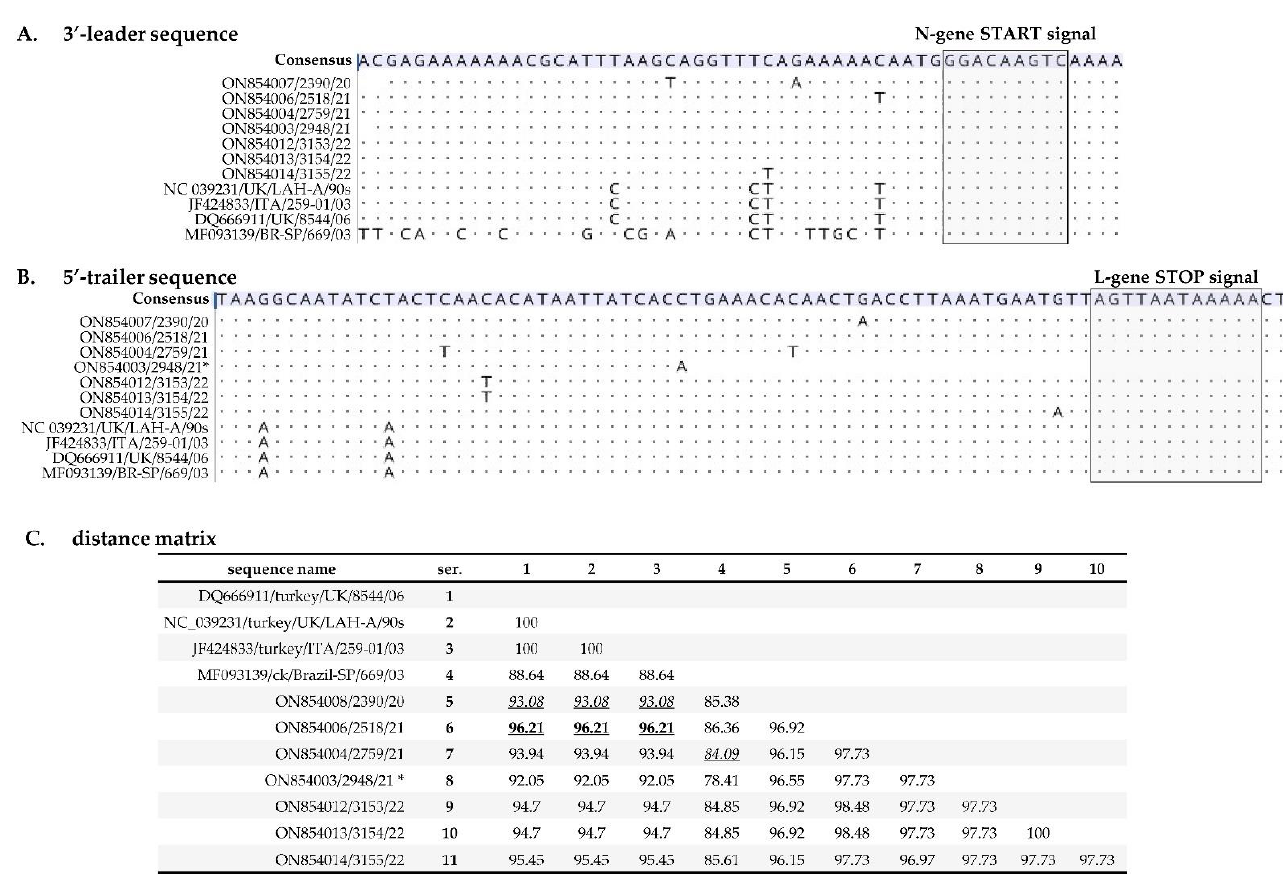
Figure 2. Analysis of ( A ) the 3′ -leader and ( B ) the 5′ -trailer regions of the aMPVs identified in this study compared to previously reported European and Brazilian strains. The transcriptional start and stop signal sequences are boxed for N- and L-genes, respectively. Dots in the alignments indicate identical nt. ( C ) Distance matrices of concatenated sequences of the 3′ -leader and 5′ -trailer regions. The highest and lowest nt identities between the Mexican, European, and Brazilian strains are underlined (in bold and italicized fonts, respectively). The low nt identities in the sequence 2948/21 (marked with asterisk “*”) could be attributed to the incomplete 3′ -leader (n = 54 nt) and 5′ -trailer (n = 34) as explained in the text. Isolate/strain names include GenBank accession number, avian species, country, and year of sample collection.